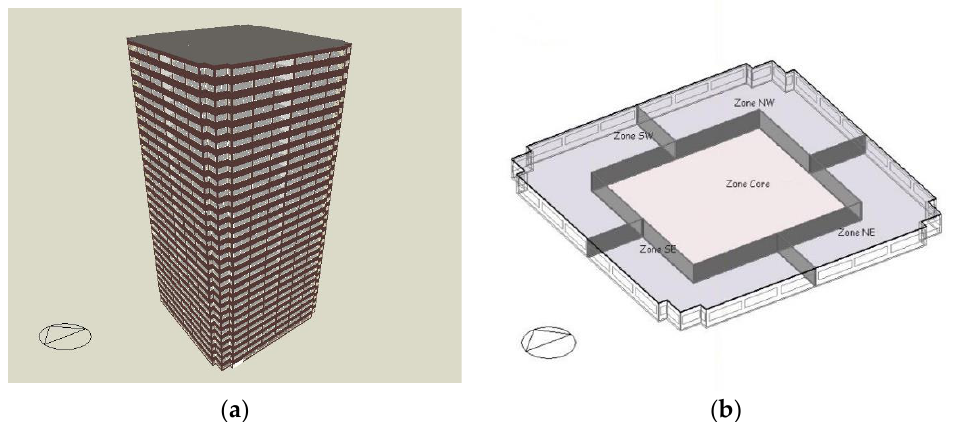
Figure A1. Hybrid space filling design method for case design of BPD in [22].